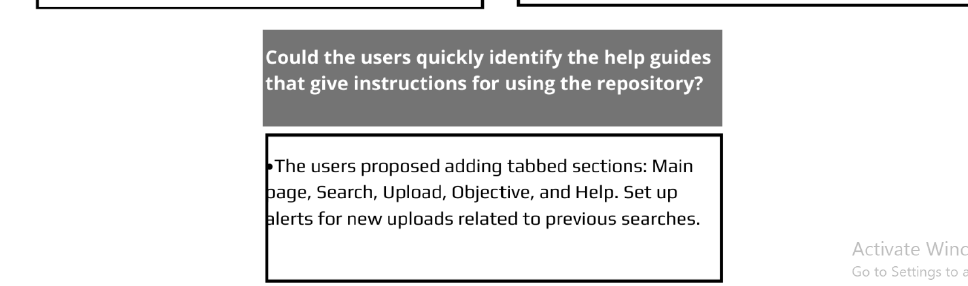
Figure 6. Results of user interface design. (Own